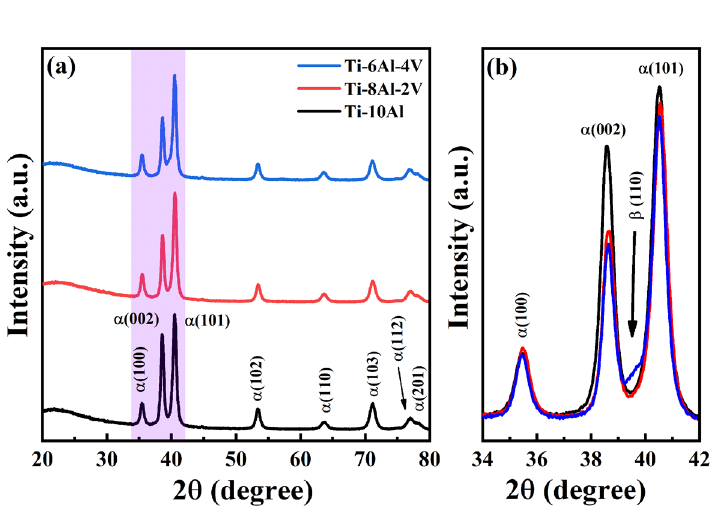
Figure 2. Phase composition analysis: ( a ) extended and ( b ) zoomed XRD